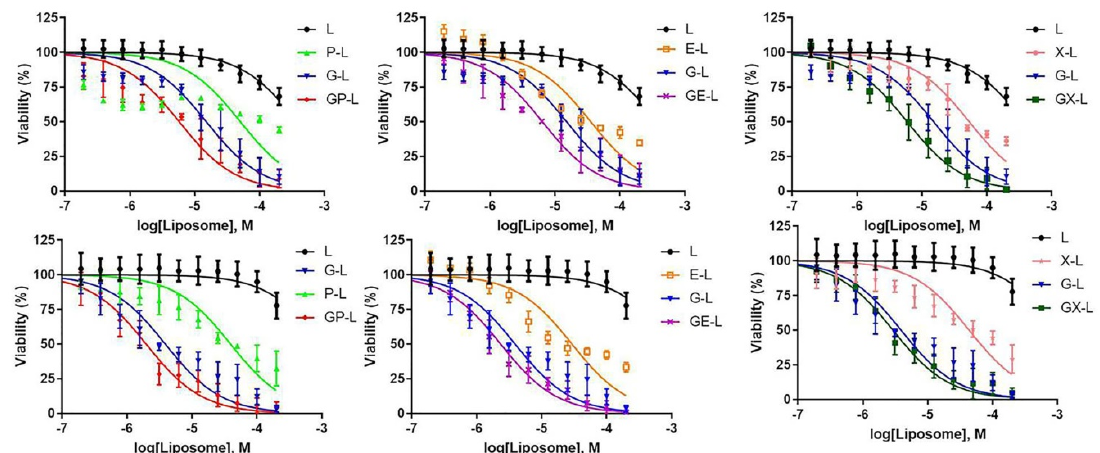
Figure 4. In vitro cellular cytotoxicities of drug-loaded liposomes in pancreatic cancer cell lines. AsPC-1 (upper panel) and PANC-1 (lower panel) cells were treated with various drug-loaded TTP-conjugated liposomes for 72 h. Then, cell viability was determined with cell titer glow assay. Dual drug-loaded liposomes showed a higher reduction in cell viability compared to single drug-loaded liposomes of each combination in all cell lines. Each data point represents the quadruplet results obtained from a single experiment. Abbreviations: L-liposome only; P-L represents liposomal paclitaxel; E-L represents liposomal erlotinib, X-L represents liposomal XL-184; G-L represents liposomal gemcitabine; GP-L represents liposome loaded with both gemcitabine and paclitaxel; GE-L represents liposome loaded with both gemcitabine and erlotinib, GX-L represents liposome loaded with both gemcitabine and XL-184.